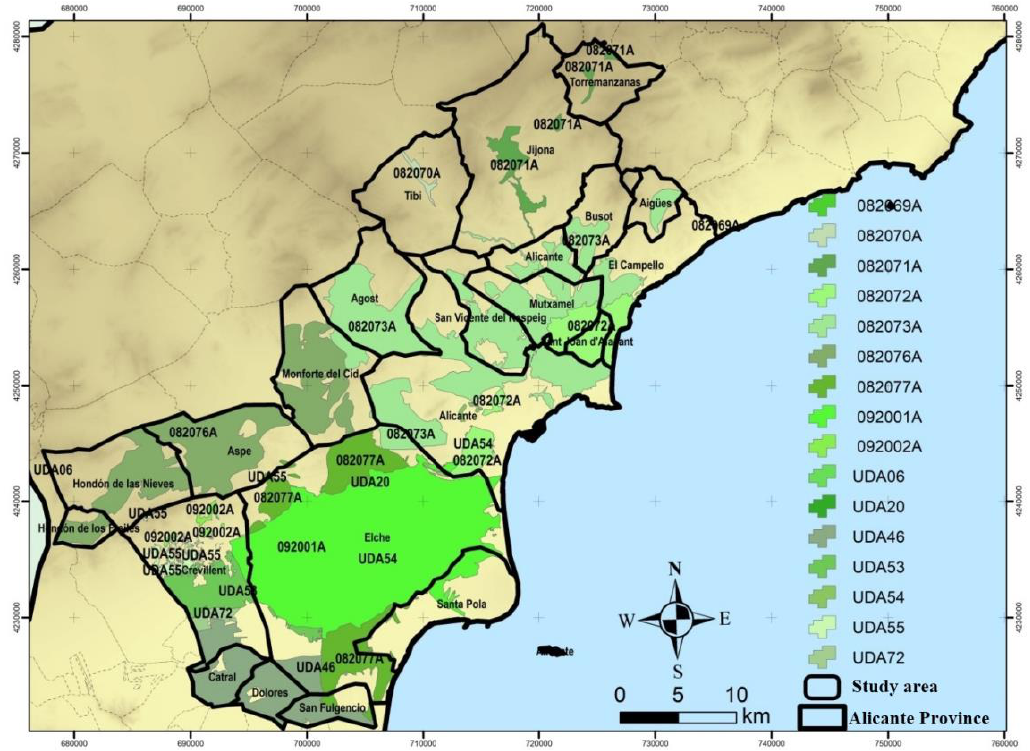
Figure 5. Agricultural water demands (in Spanish UDAs) located in the study area. Source: elaborated with information from [34,35].